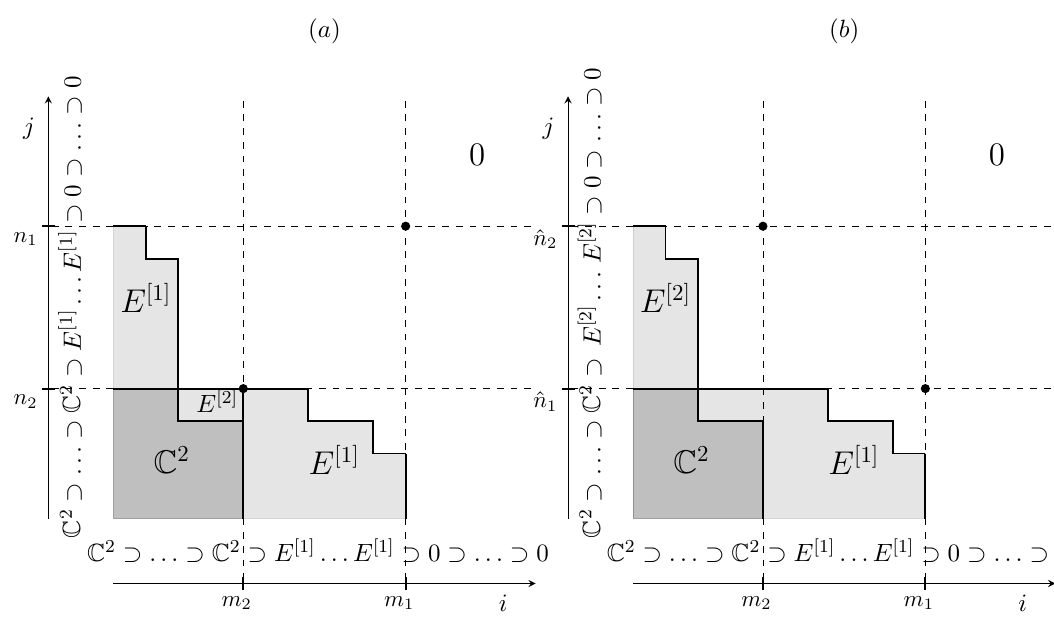
Figure 4 . Example of dual bifiltrations with all the cut out Young diagrams being non empty. (a) m 1 > m 2 , n 1 > n 2 ; (b) m 1 > m 2 , ˆ n 1 < ˆ n 2